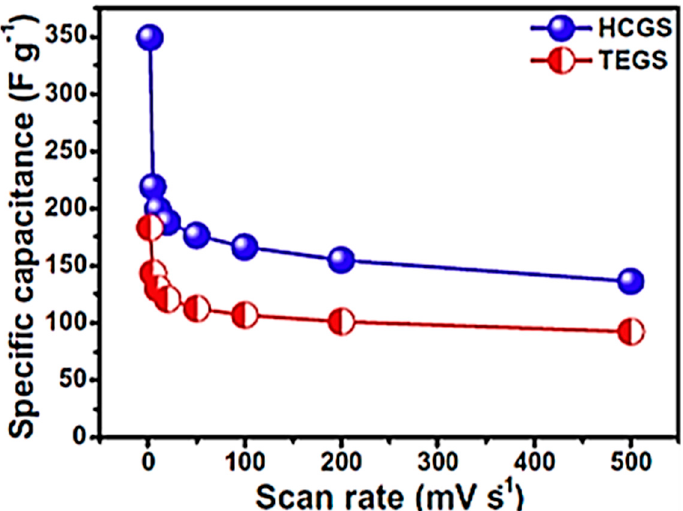
Figure 2. Specific capacitance of HCGS and TEGS electrodes at different scan rates in 6 M KOH solution [42]. HCGS = highly corrugated graphene sheets; TEGS = thermally exfoliated graphene sheets. Reproduced with permission from Elsevier.